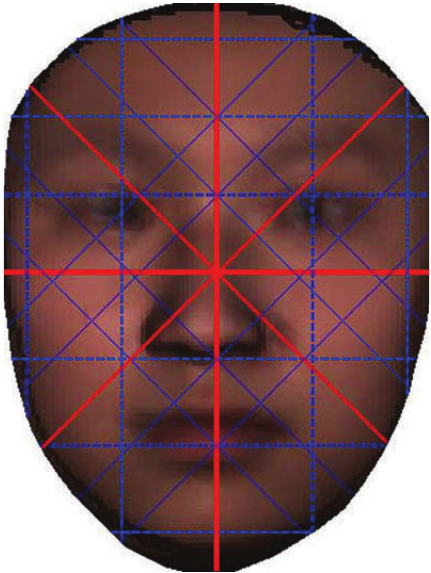
Figure 7: Saltire-over-cross feature—the gray values of pixels in the 22 pixel lines are selected as features.